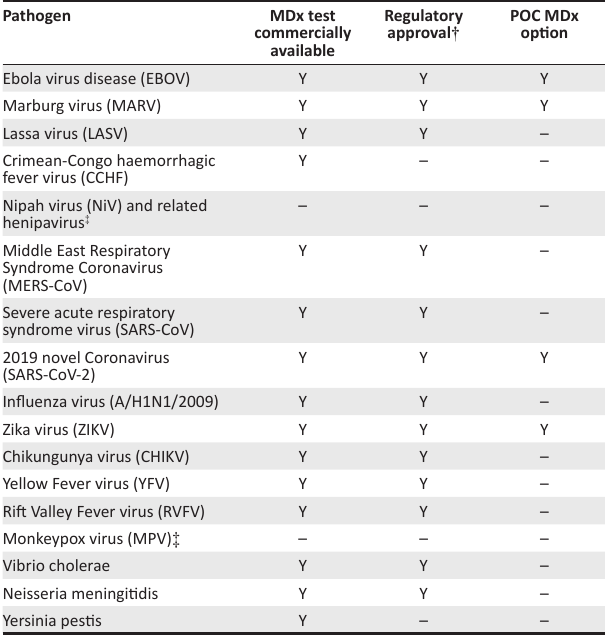
TABLE 1: Availability of molecular diagnostic tests for select outbreak